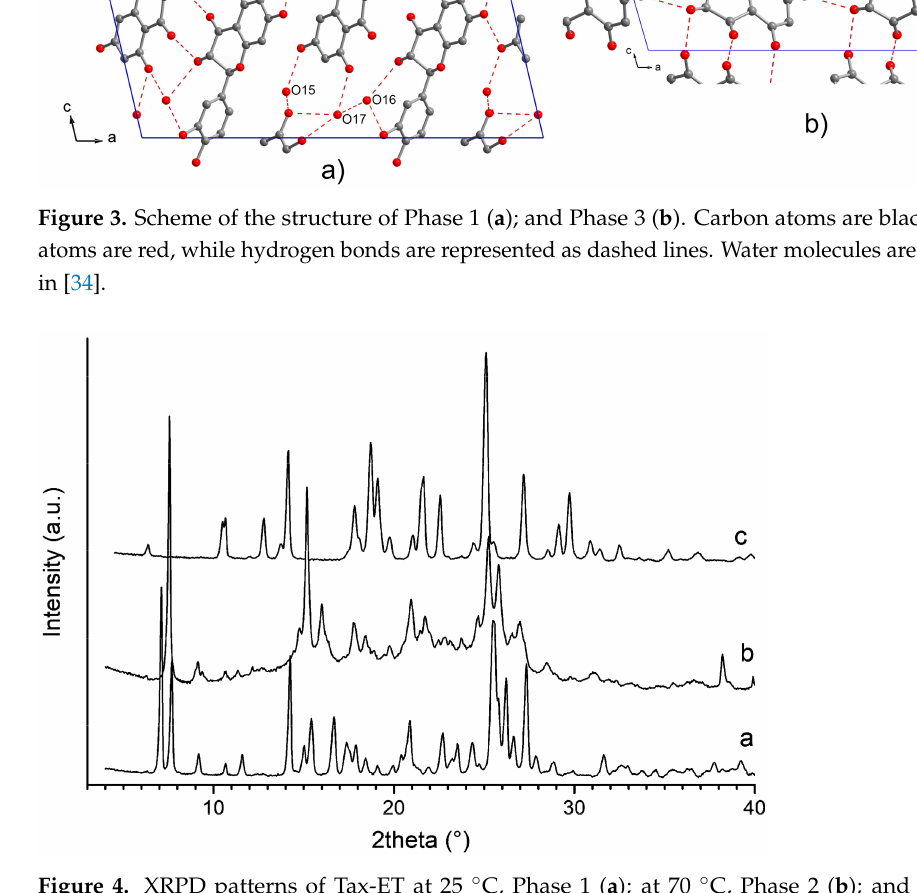
Figure 4. XRPD patterns of Tax-ET at 25 ◦ C, Phase 1 ( a ); at 70 ◦ C, Phase 2 ( b ); and at 120 ◦ C, Phase 3 ( c